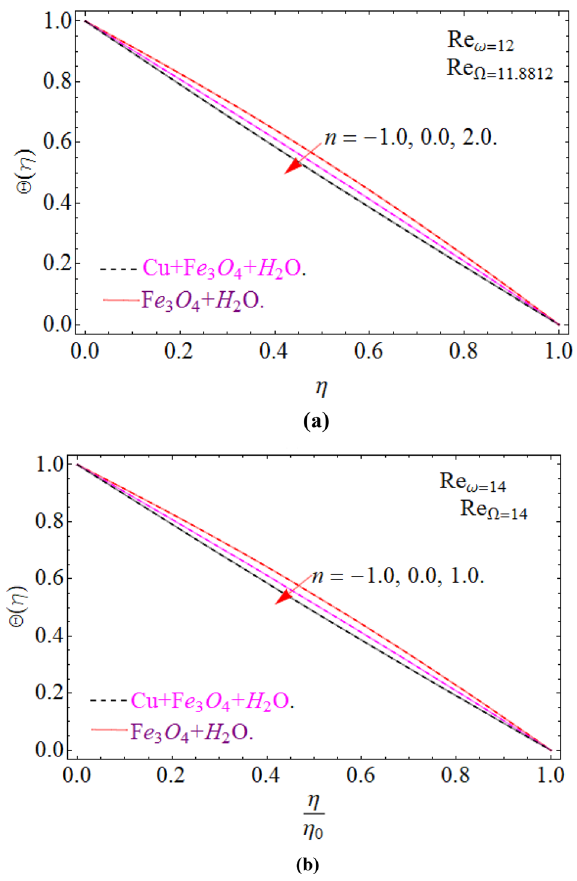
Figure 18. Impression of Θ( η ) amongst a co-rotating disk and cone at three different radial exponents with Re ω /Re Ω = 1.01. ( a ) Re ω = 12 and ( b ) Re ω =